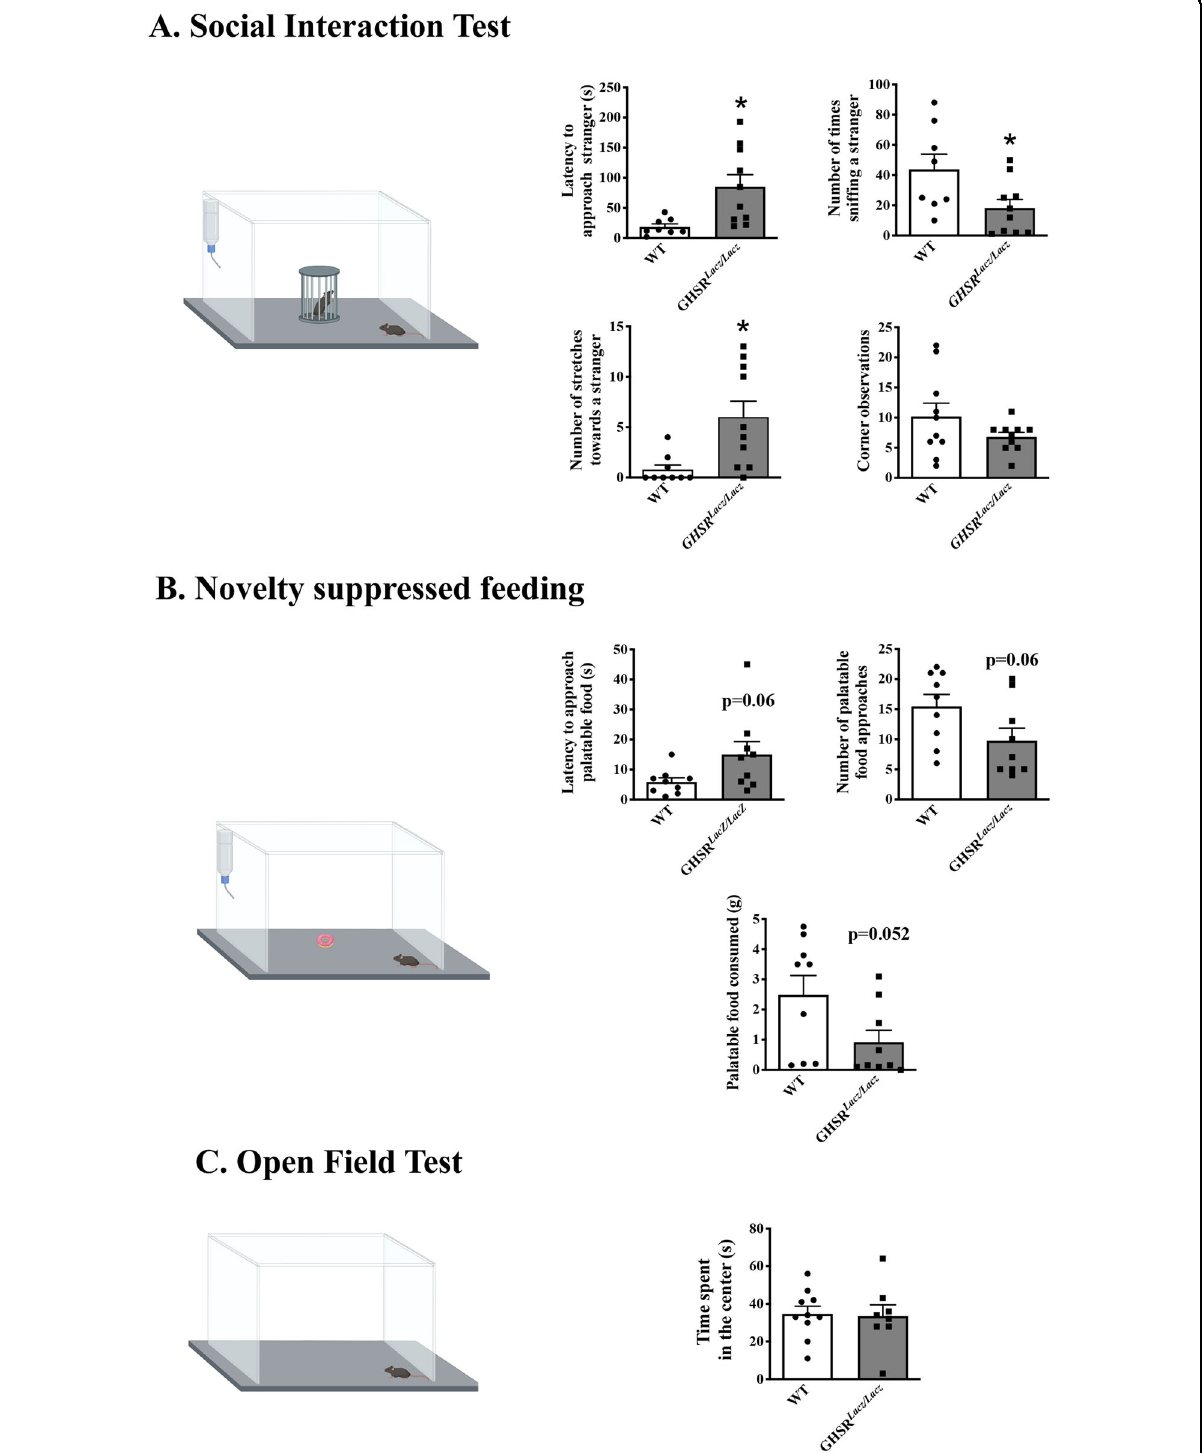
Fig. 1 Behavioral responses in GHSR KO mice of the GHSR Lacz/Lacz strain. As shown in Panel A , GHSR Lacz/Lacz mice ( n = 10) showed longer latencies to approach a stranger and a lower frequency of investigation than their WT littermates ( n = 8) ( p < 0.05). In contrast, GHSR Lacz/Lacz mice showed more corner observations, a behavior associated with social vigilance ( p < 0.05). As shown in Panel B , GHSR Lacz/Lacz mice show similar latency to approach a palatable snack, approach the snack with the same frequency, and consumed similar amounts of the palatable snack as WT mice (see Panel B ). Finally, GHSR Lacz/Lacz mice did not differ from WT mice on behavior in the open fi eld test (see Panel C ). * p <